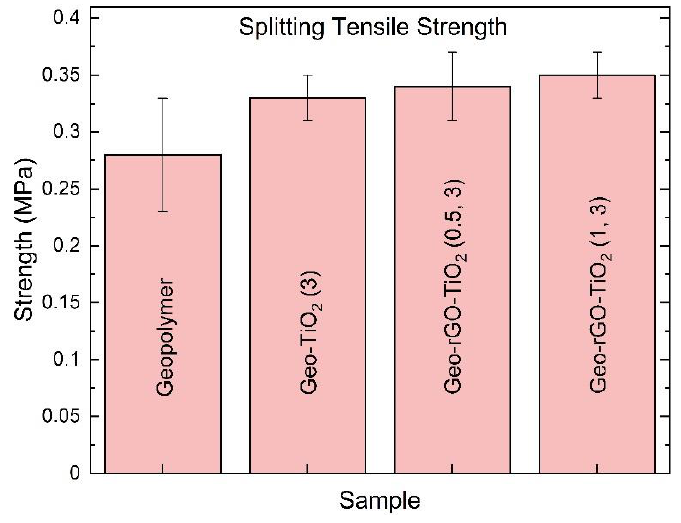
Figure 15. The magnitude of the splitting tensile strength of the unsupported pervaporation mem- branes. The error bars were taken as standard deviation of three specimens for each sample.